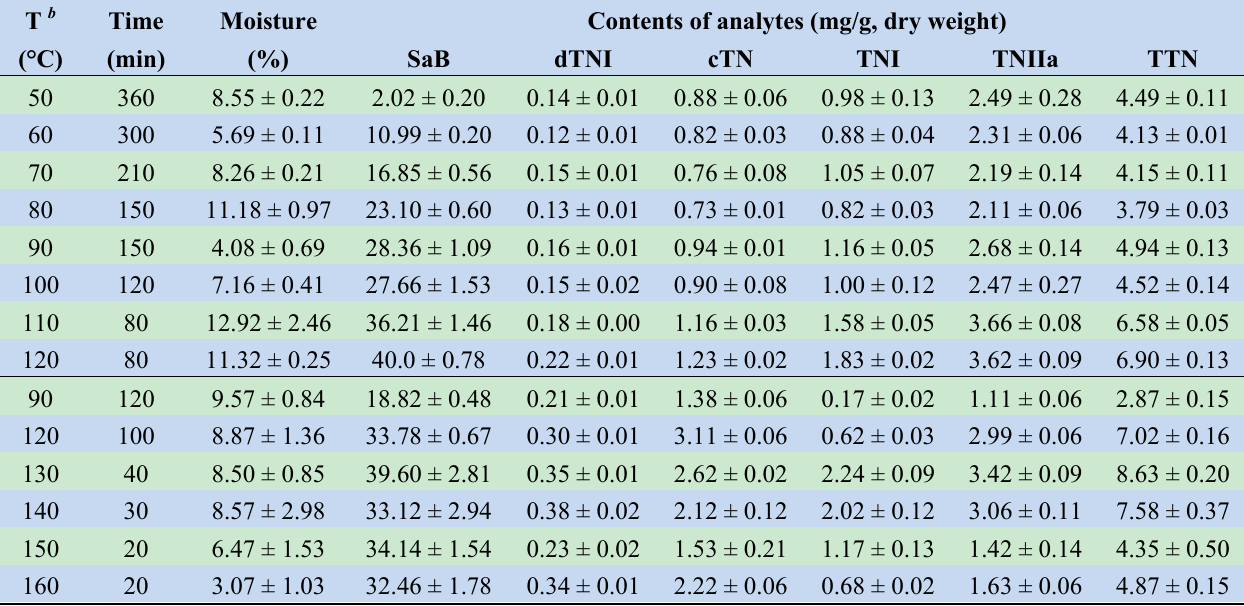
Table 1. Drying efficacies and levels of five analytes in dried samples with standard moisture (S-values) a .